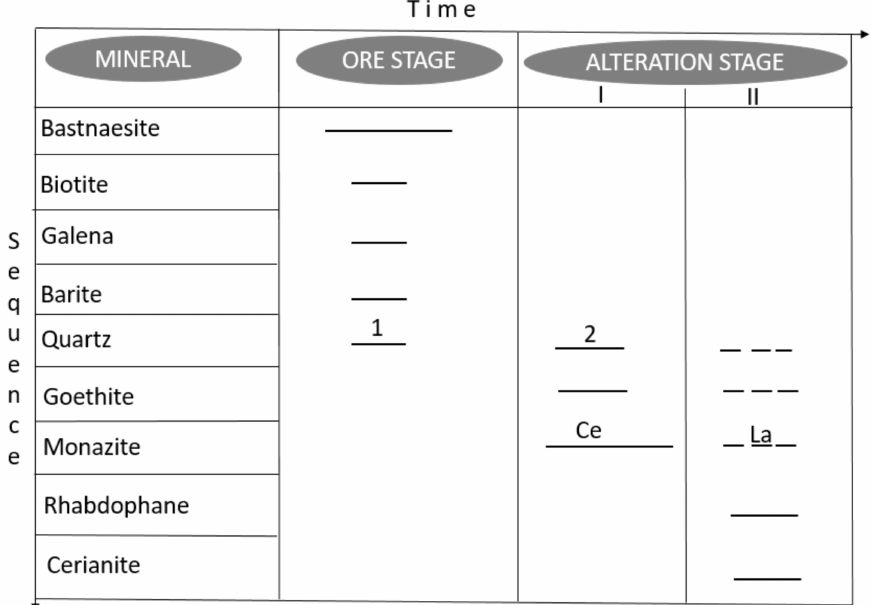
Figure 12. Synthetic paragenetic sequence for the Gakara REE mineralization; established from various deposits and occurrences (i.e., the degree of alteration stages is not equal for all